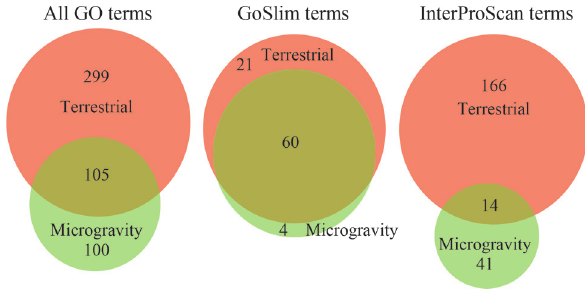
Figure 5 - Gene ontology Venn diagrams for overlap between micro- gravity and terrestrial SSH library top Blast hits of all contigs and single- ton